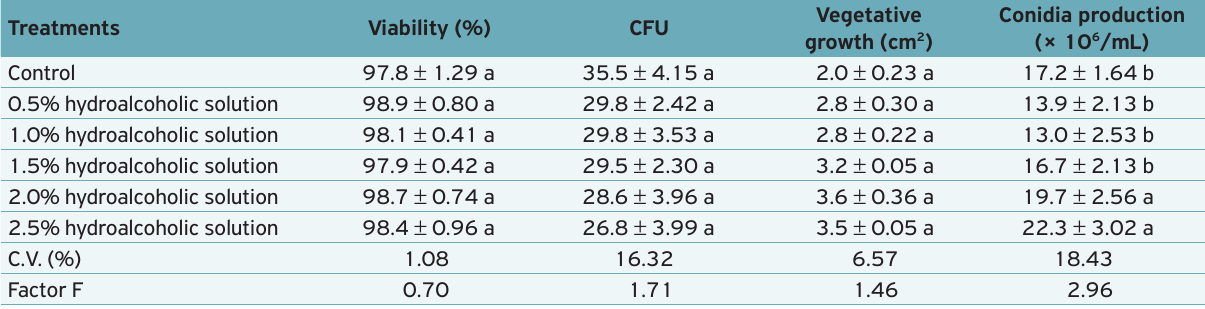
Table 2. Viability of conidia, colony forming units, vegetative growth and production of Metarhizium anisopliae (UNIOESTE 22), subject to different alcoholic degrees (26 ± 1°C and 12h photoperiod).